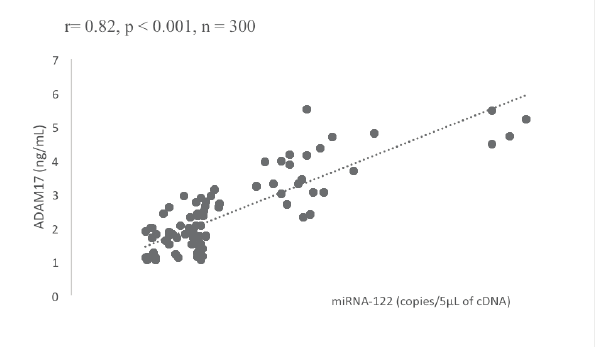
Figure 1: Correlation Graph of ADAM-17 and miRNA-122.